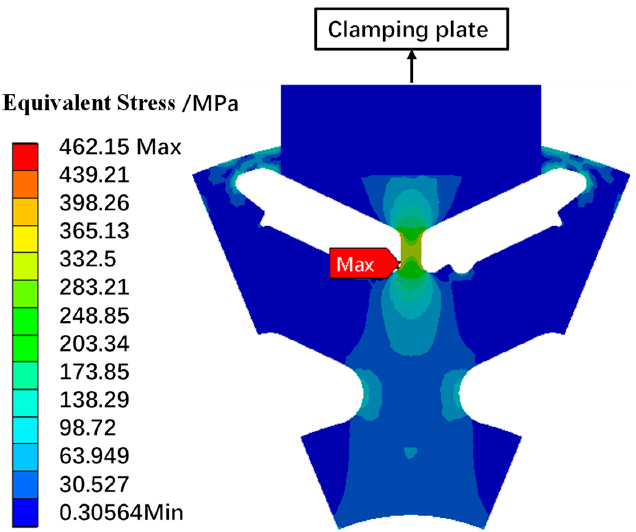
Figure 24. Rotor stress distribution under a tensile load of 600 N.